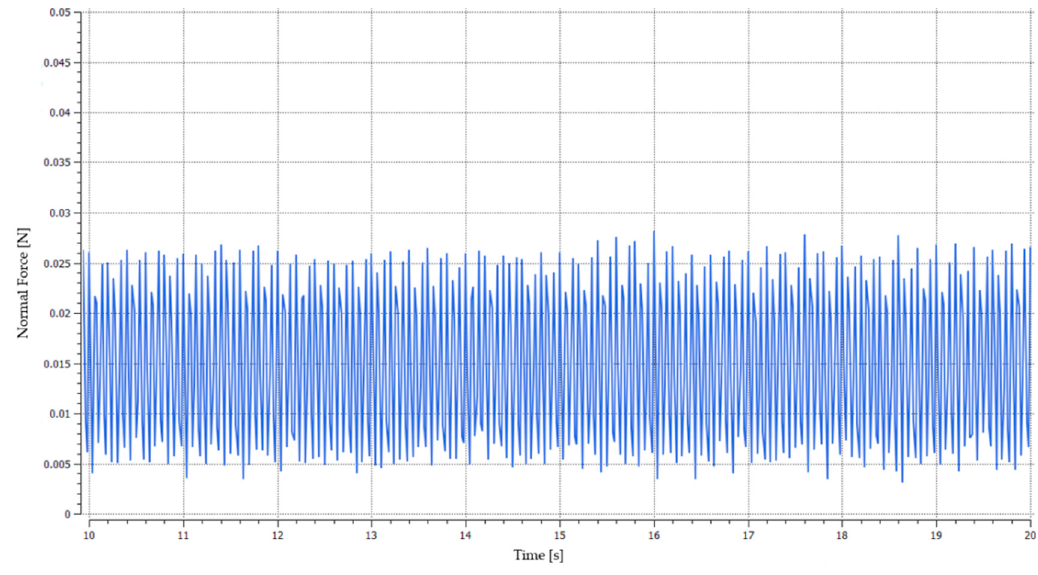
Figure 6. Standard deviation of average force acting on the fruit in the normal direction vibrating transport.